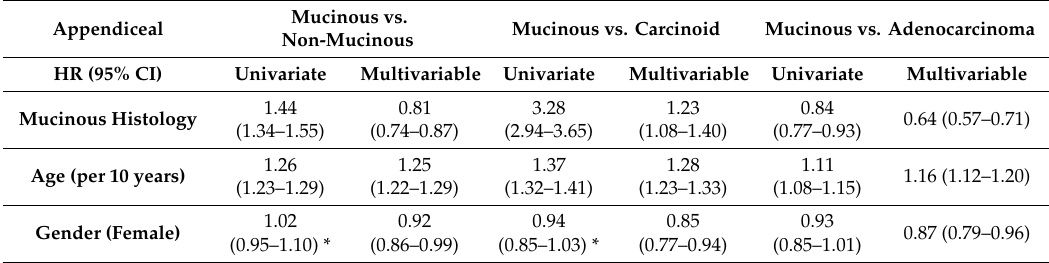
Table 14. Derived univariate and multivariable Cox-proportional hazard ratios (HR) of mortality for appendiceal